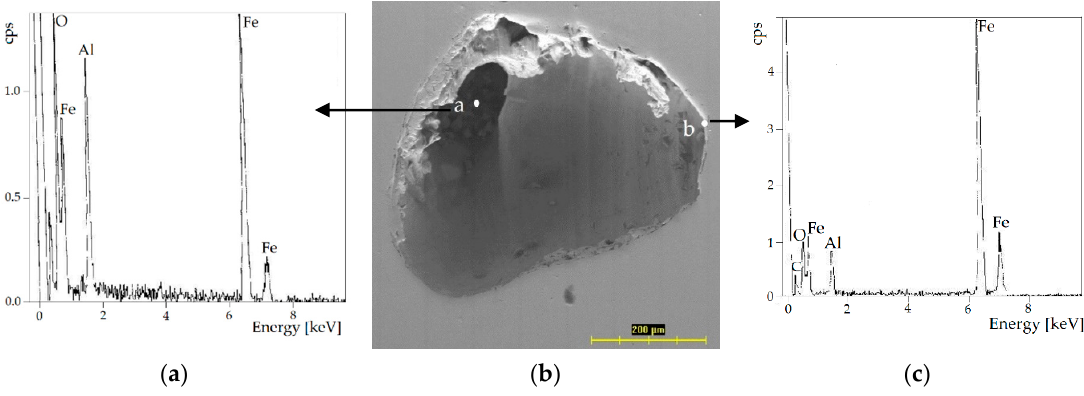
Figure 14. Cross-section through the TWB1pore. ( a ) EDX analysis of the pore; ( b ) SEM of the cross-section; ( c ) EDX analysis of the edge of the pore.